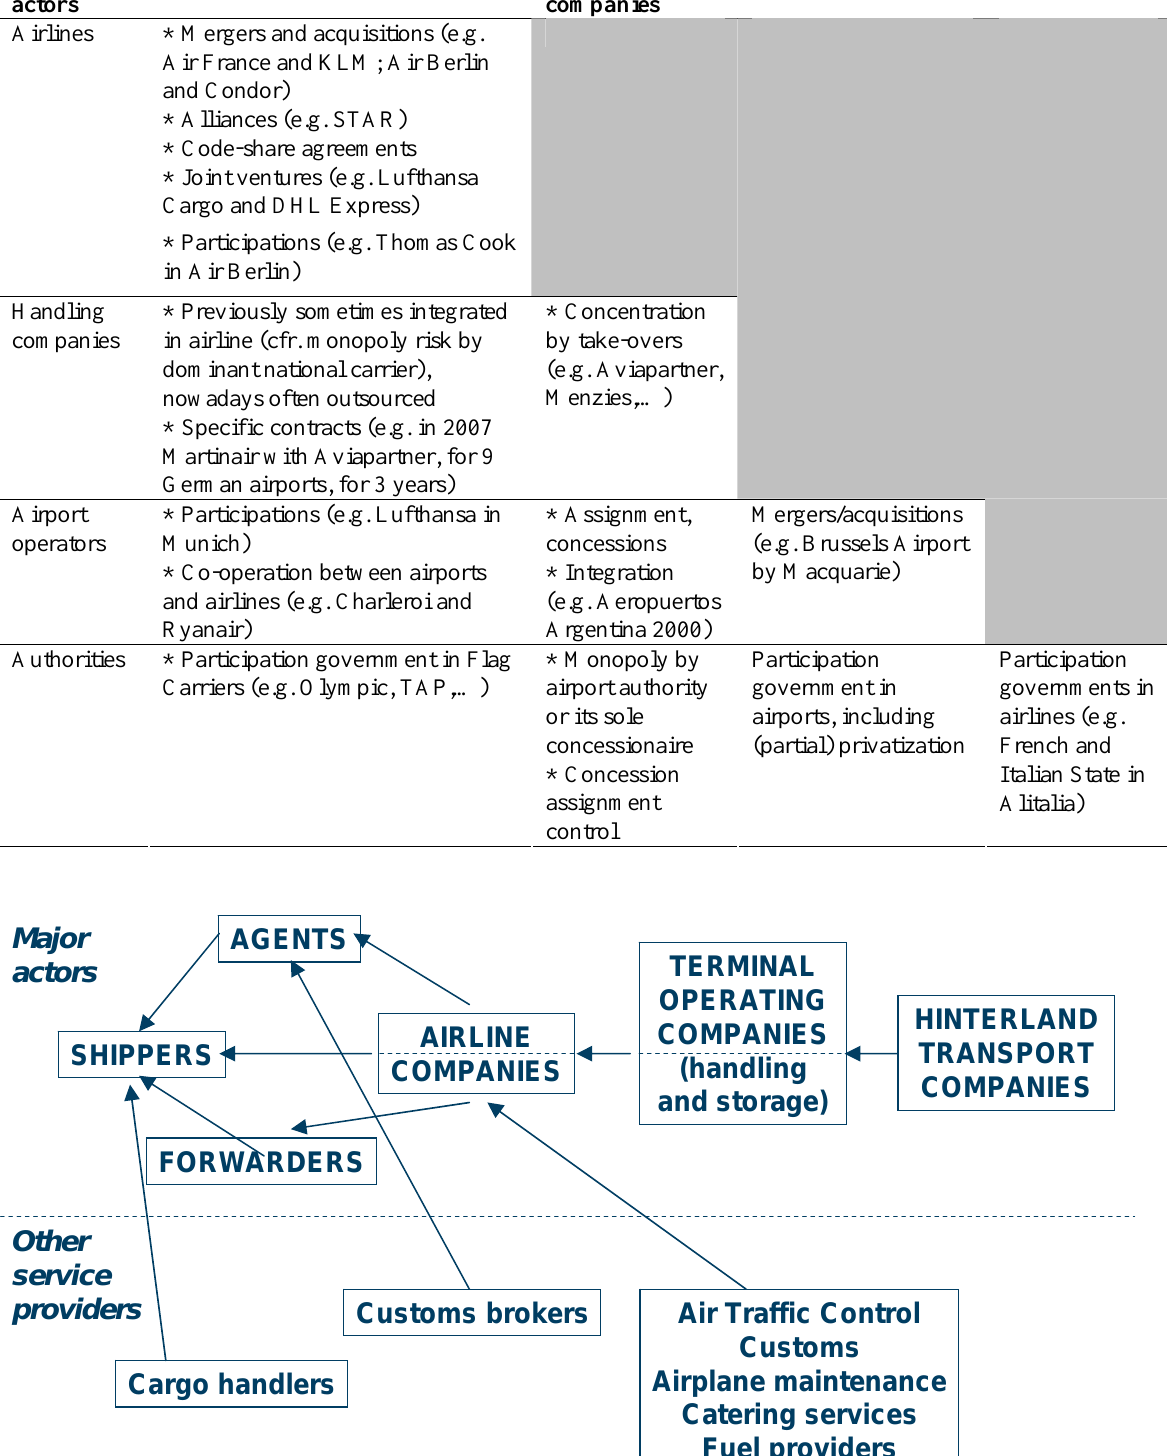
European Journal of Transport and Infrastructure